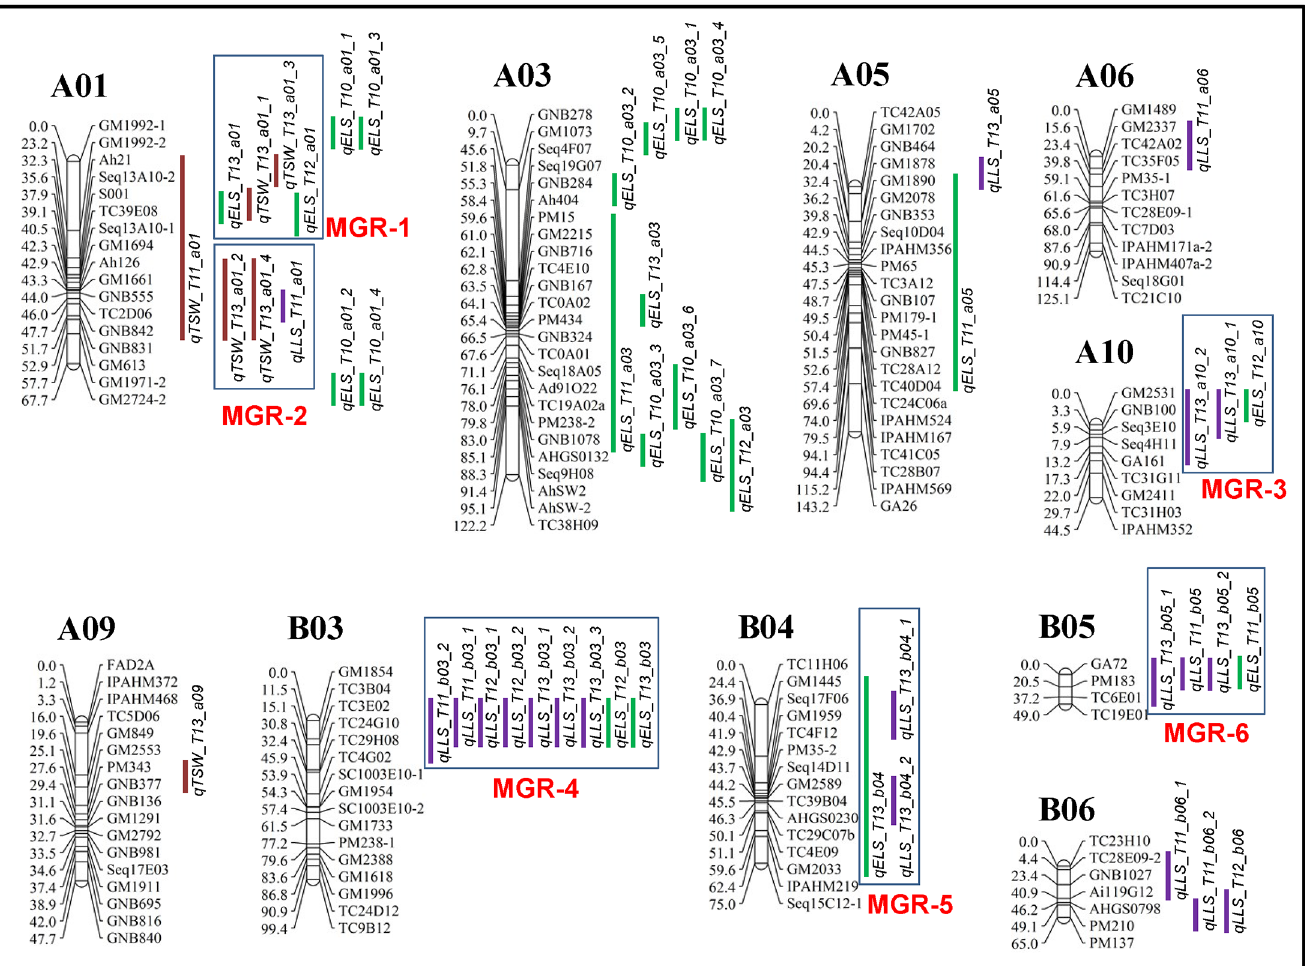
Fig 3. Genetic map of the S-population from the cross SunOleic 97R and NC94022 showing genomic regions harboring 48 QTLs for late leaf spot, early leaf spot and Tomato spotted wilt virus. A total of six major genomic regions (MGR) were found to have QTLs controlling more than one